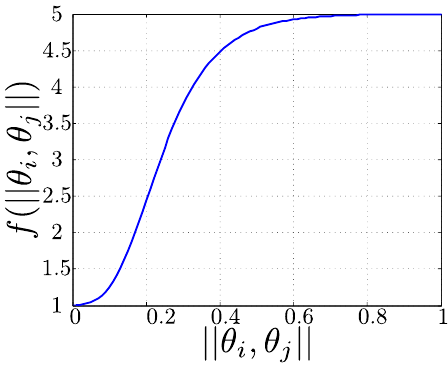
Figure 2. Penalization Equation (3): a = 4, b = − 7.5 and c = −